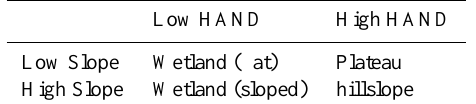
Table 1. Criteria for land classification using HAND and slope.